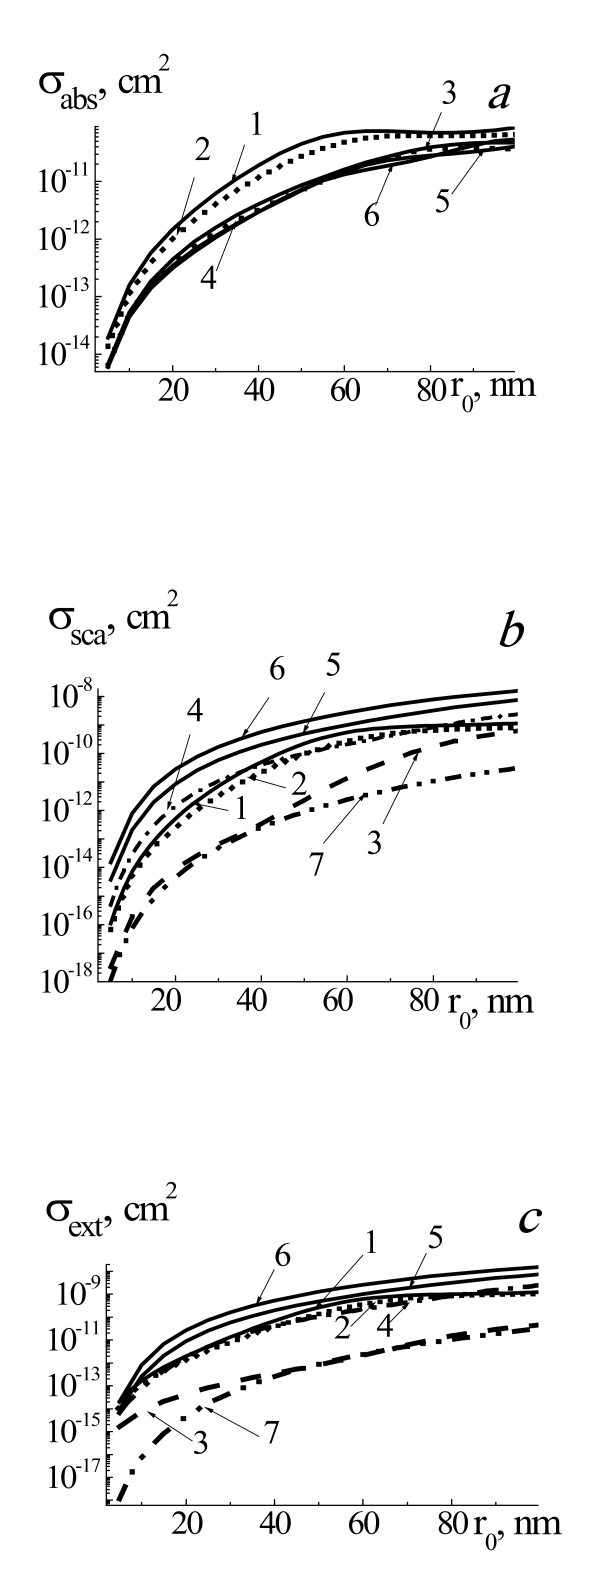
Efficiency cross sections of σabs (a), σsca (b), and σext (c) of laser radiation. With wavelength 633 nm by two-layered spherical system gold NP-core, water vapor-shell placed in water for the range of NP radii r0 = 5 to 100 nm, and radii of system r1 = r0 (1, pure gold NP, straight line), r1 = r0 + 0.1r0 (2, dotted line), r1 = r0 + 1r0 (3, dashed line), r1 = r0 +2r0 (4, dashed-dotted line), r1 = r0 + 3r0 (5, straight line), and r1 = r0 + 4r0 (6, straight line), and for homogeneous vapor bubble with r0 (7, dashed-double dotted line).